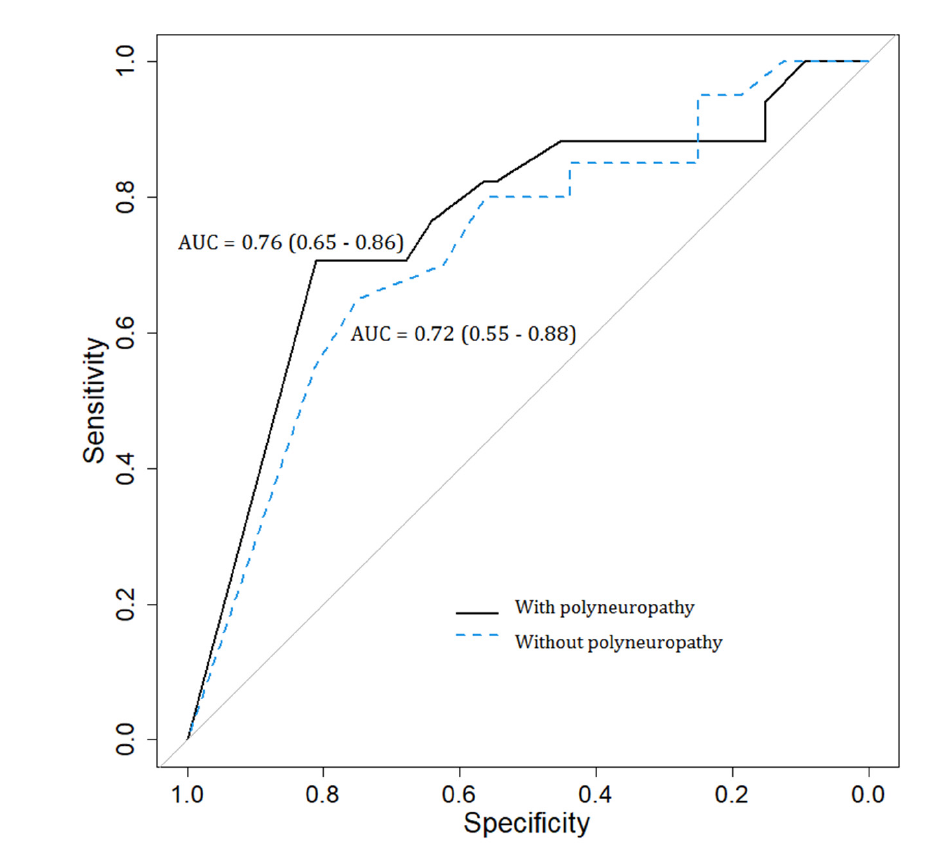
Figure 1. Area under the curve values of the BCTQ questionnaire according to nerve conduction studies in patients with and without diabetic polyneuropathy.